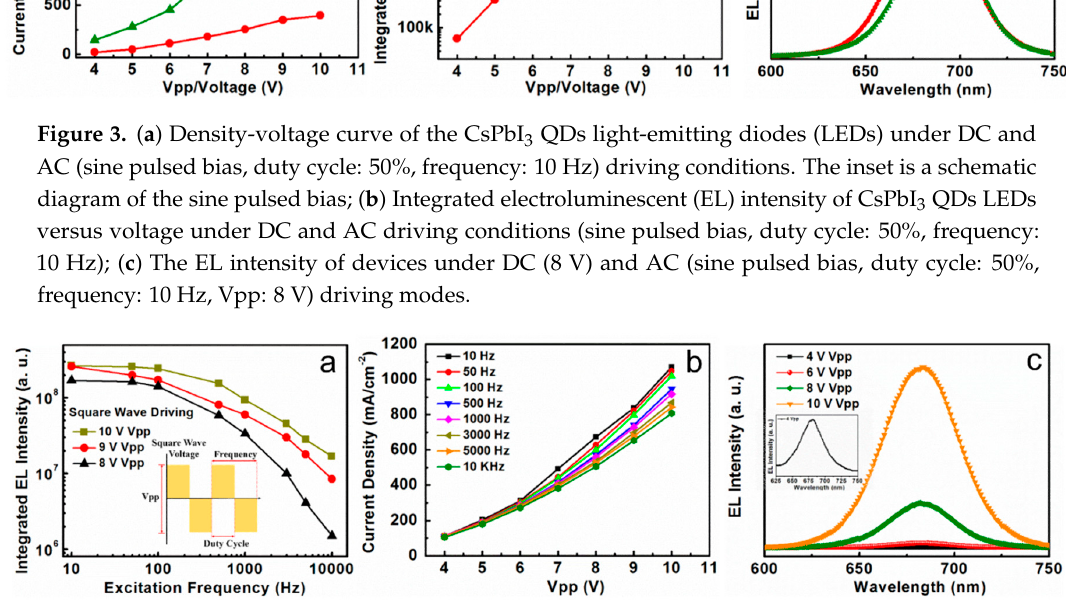
Figure 4. ( a ) The integrated EL intensity versus excitation frequency (from 10 Hz to 10 kHz) under different driving voltages with 50% duty cycle square pulsed bias. Illustration is a schematic diagram of square wave waveform; ( b ) Current density-voltage (J-V) characteristics of devices under different excitation frequency with 50% duty cycle square pulsed bias; ( c ) The EL intensity versus Vpp (from 4 to 10 V) with 10 Hz excitation frequency and 50% duty cycle under square pulsed bias. The inset shows the EL spectrum of the CsPbI 3 QDs LEDs under 4 V Vpp.